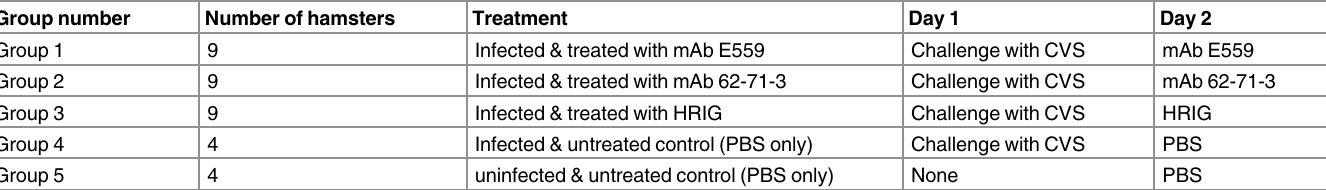
Table 3. Rabies virus challenge and administration schedule of anti-rabies mAbs in Syrian hamsters. Group